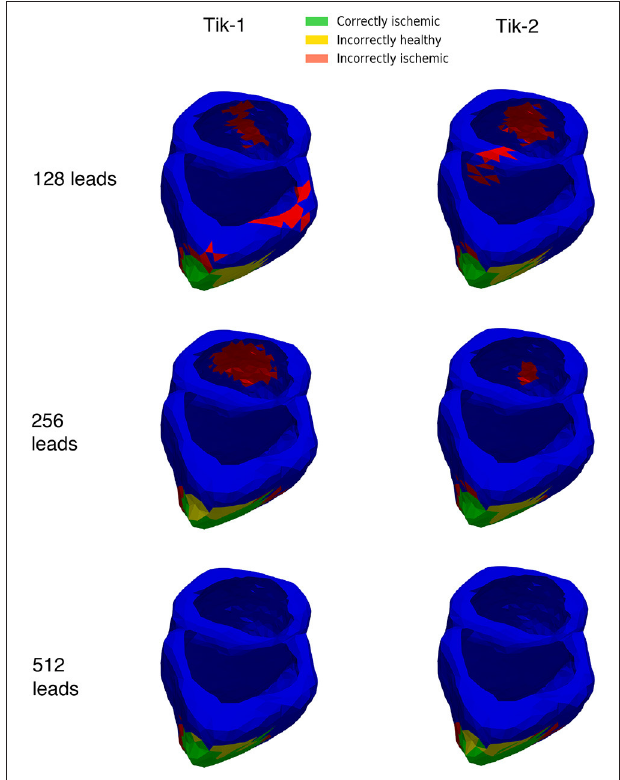
FIGURE 7 | 3D ventricle detection results for 1st and 2nd order Tikhonov solutions for 128, 256, and 512 leads. Green areas represent the successful identification of the ischemic lesion, yellow areas are ischemic which were not identified, and red areas indicate areas incorrectly identified as ischemic.